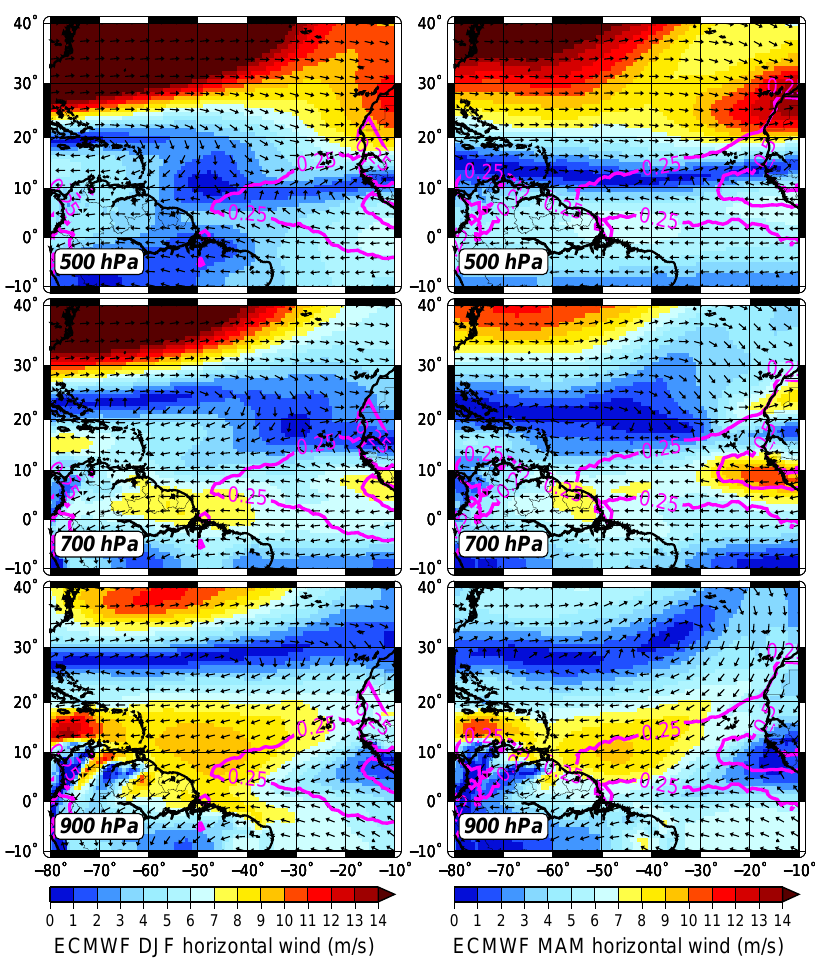
Fig. 8. Horizontal wind from ECMWF at three pressure levels (900hPa – bottom; 700hPa – middle; and 500hPa – top) during winter (DJF – left) and spring (MAM – right) seasons averaged over the same period as for CALIPSO. The vectors indicate the direction, and the color the wind speed (ms − 1 ). The magenta isolines of 0.25 and 0.5 depict the MODIS AOD at 550 nm .